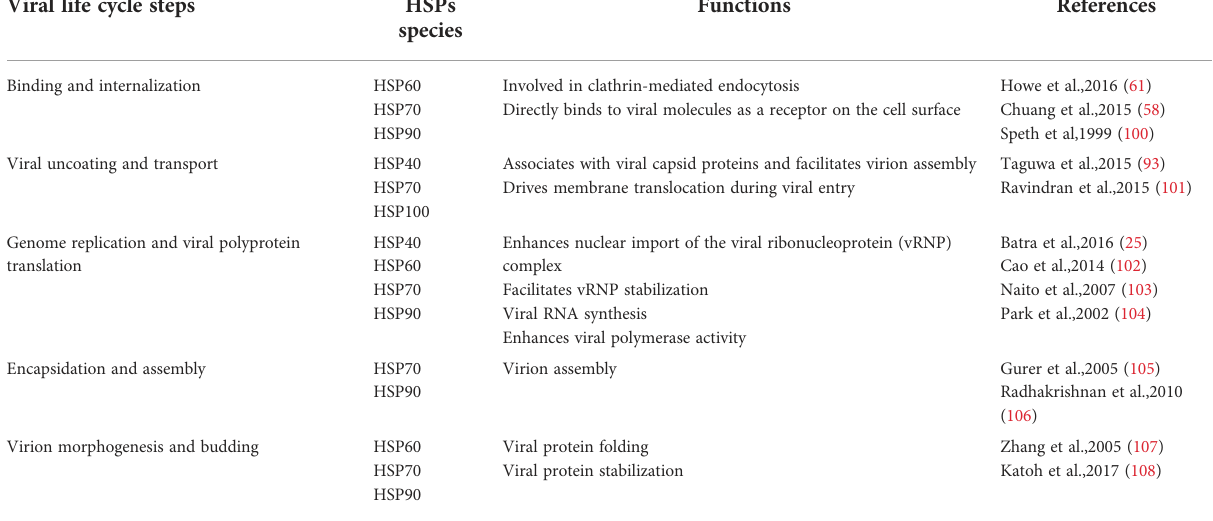
TABLE 2 The involvement of heat shock proteins in various stages of viral